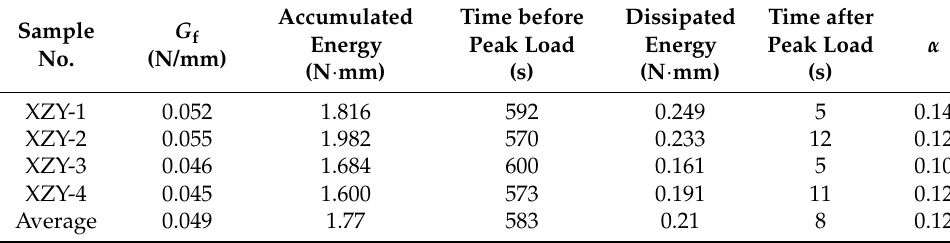
Table 6. Fracture energy parameters and bending fracture time of the coal